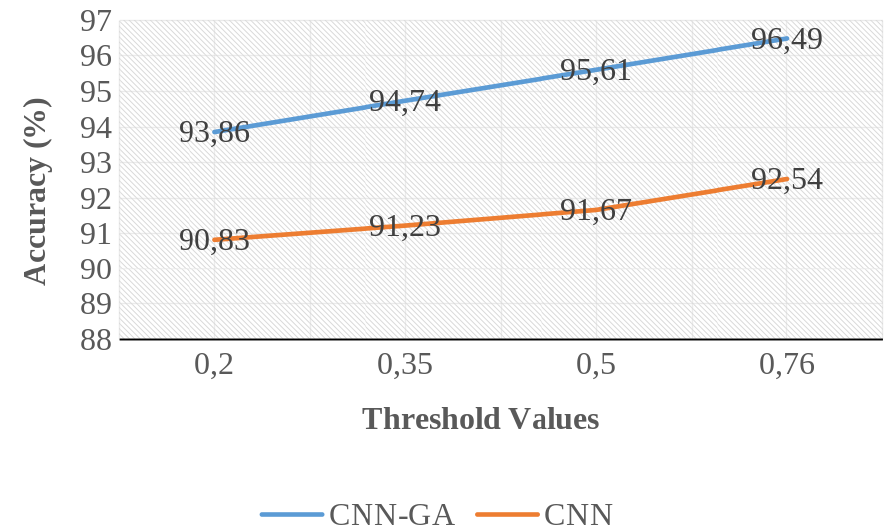
Figure 2: Graph of